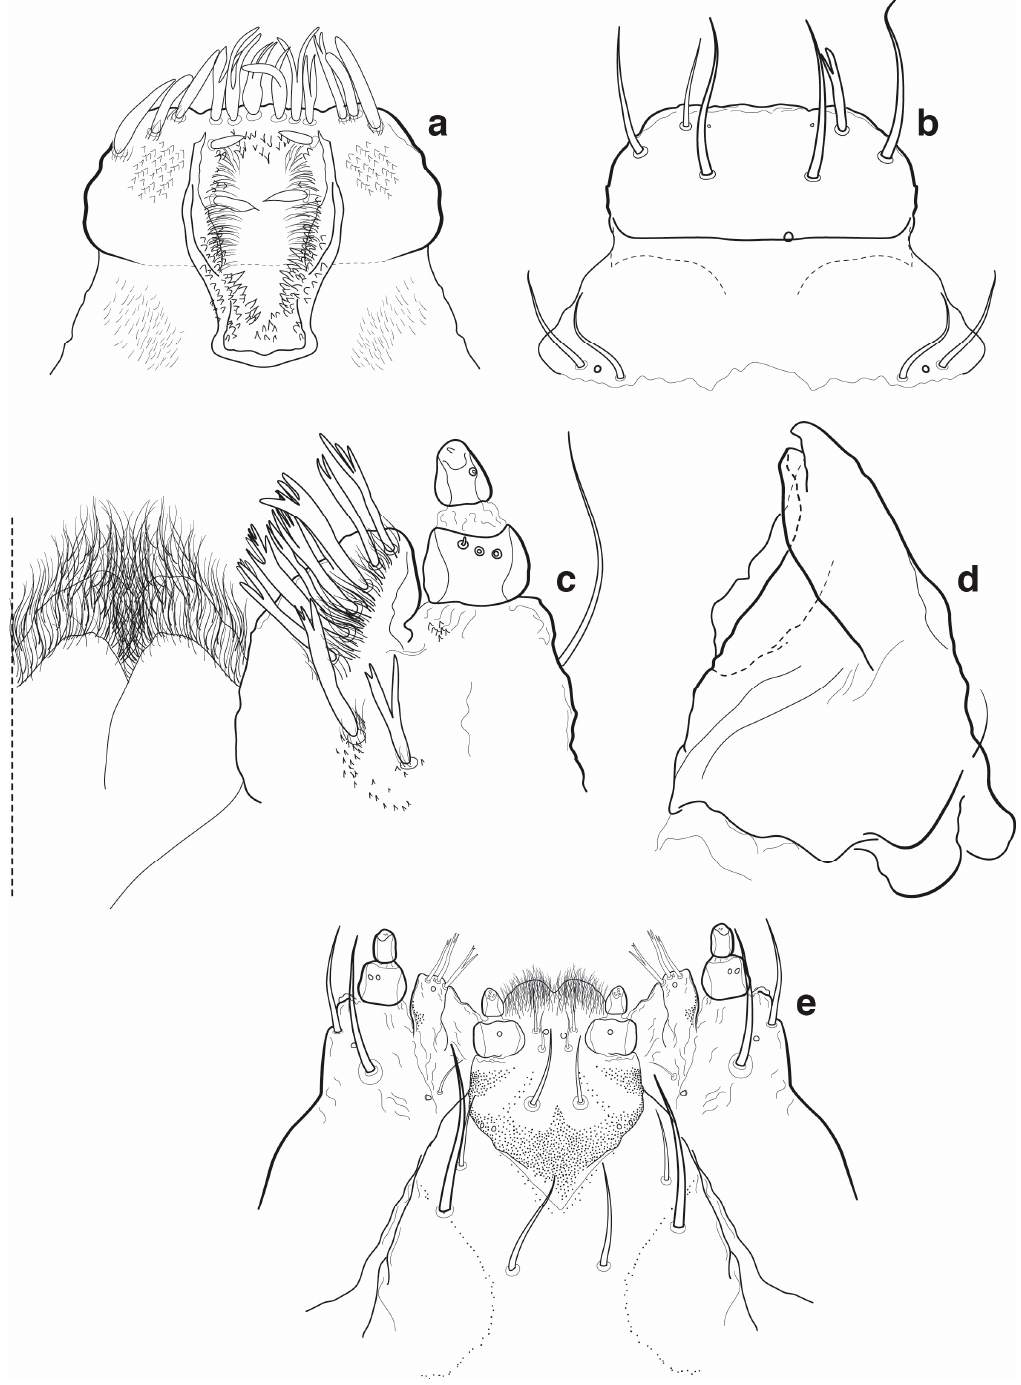
Figure 87. Temnoschoita sp. Mouthparts: ( a ) epipharynx; ( b ) clypeus and labrum; ( c ) detail of hypopharynx and maxillae, dorsal view; ( d ) mandible; and ( e ) labio-maxillary complex, ventral view.